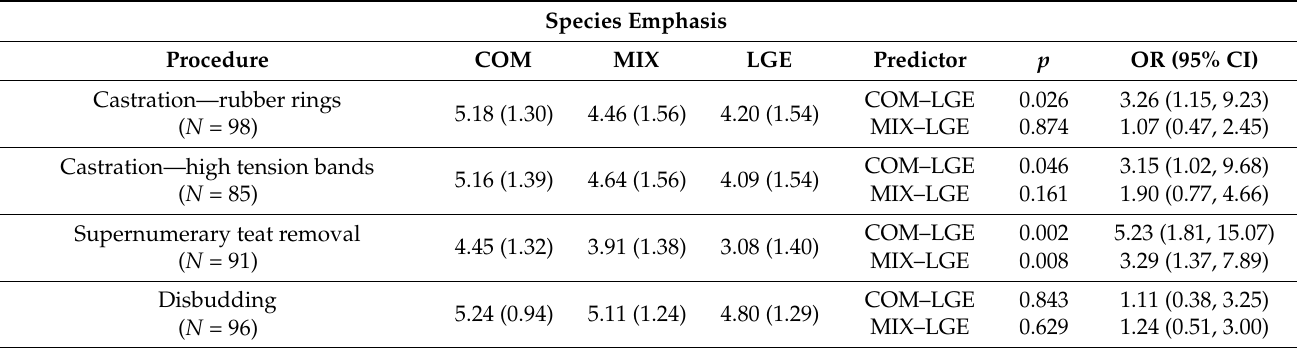
Table 9. Mean (SD) perceived postprocedural pain durations of veterinarians across certain husbandry procedures by species emphasis.